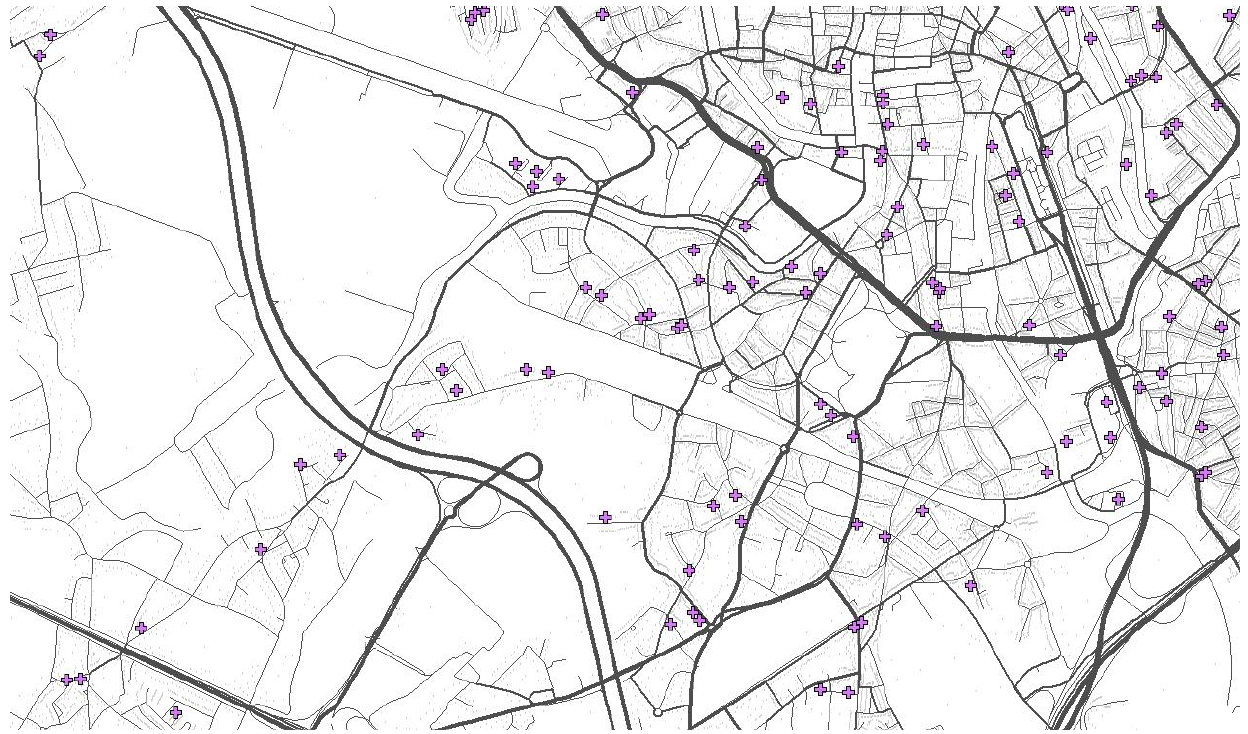
Figure 2. Map of part of the city of Gent showing the intensity of trips with local origin or destination as line thickness on a background of grey dots of dwelling addresses; crosses are survey point used in Section